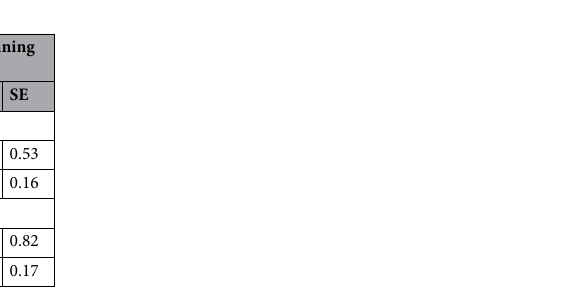
Figure 2. Distribution of heart and lung volumes for Duroc and Landrace pigs predicted from deep learning algorithms as bivariate plot ( a ) and as empirical cumulative distribution functions (ecdf) (in b,c ).